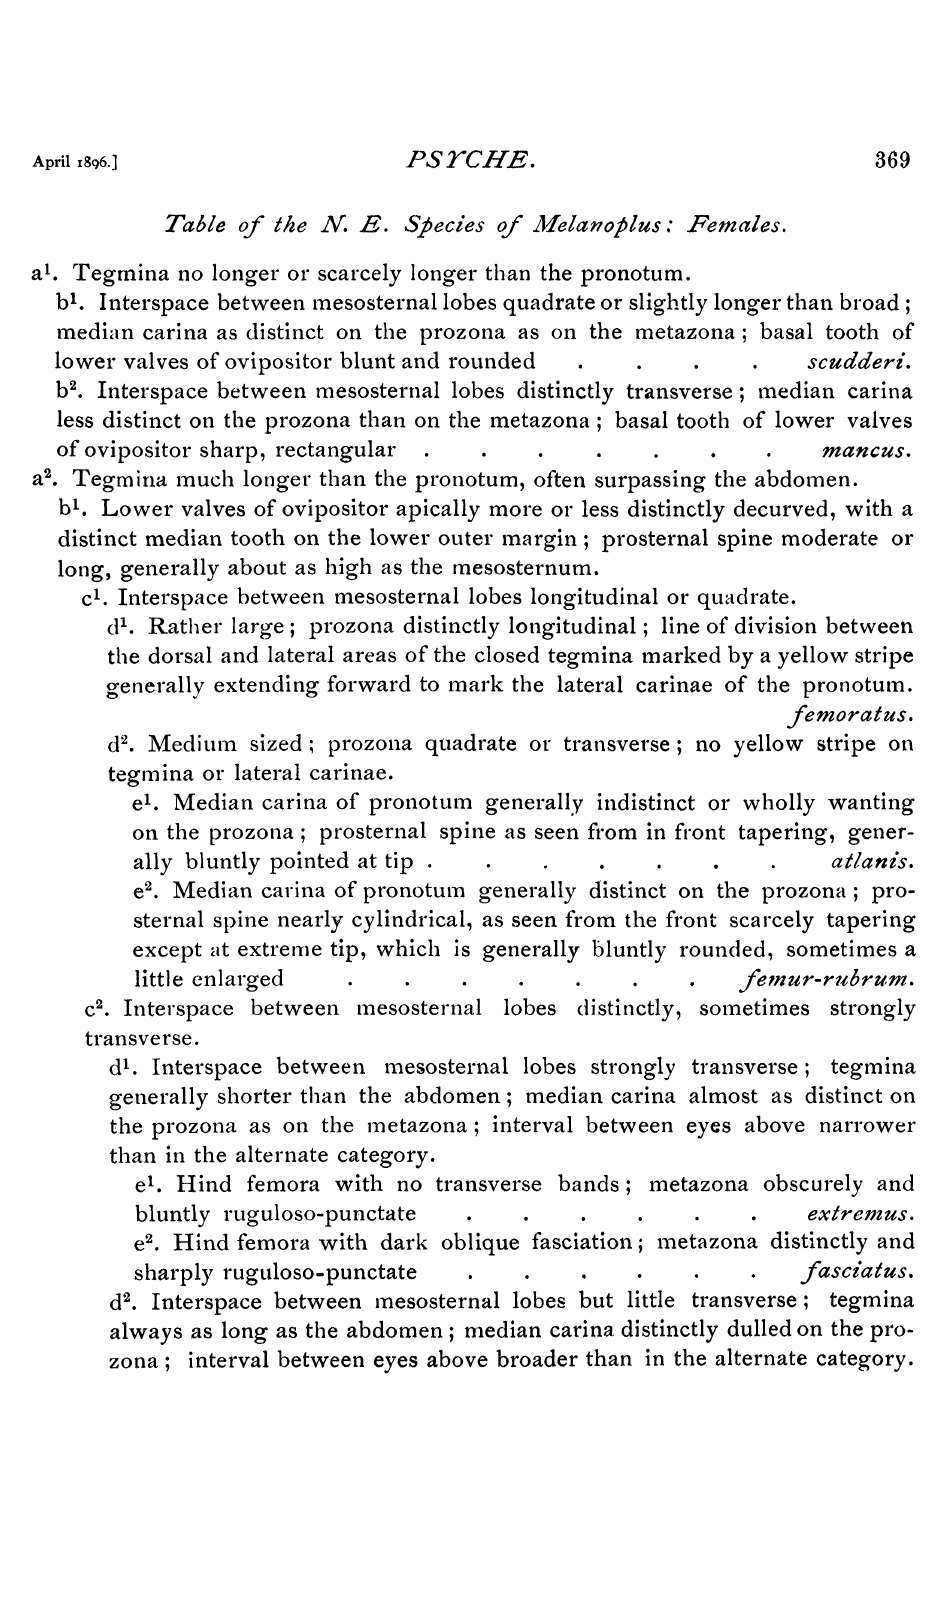
Table of the 2V. t. Sibecies of Melanoplus